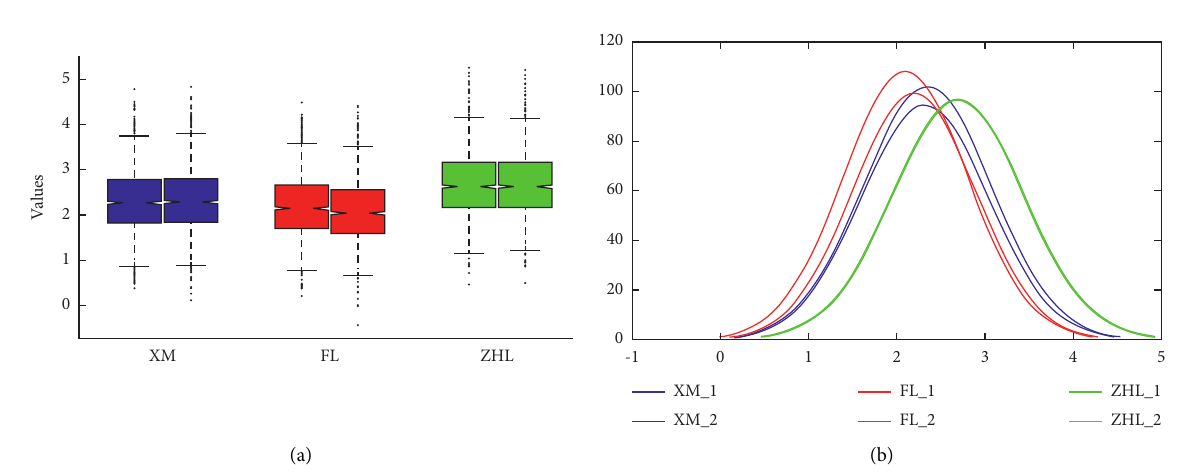
Figure 5: The box plot (a) and normal distribution (b) of the protein expression of the annual branches of the three varieties of